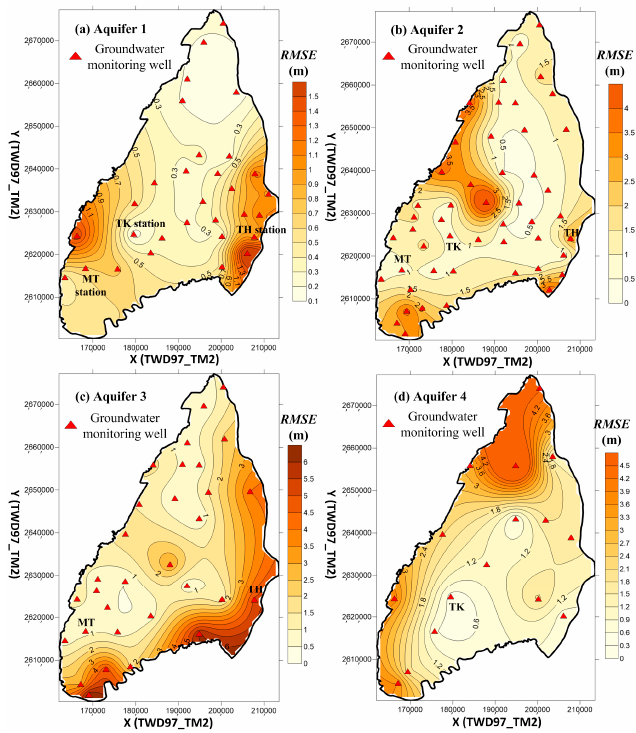
Figure 13. The spatial pattern of root mean square error (RMSE) between simulated and observed groundwater heads: ( a ) Aquifer 1; ( b ) Aquifer 2; ( c ) Aquifer 3; and ( d ) Aquifer 4.